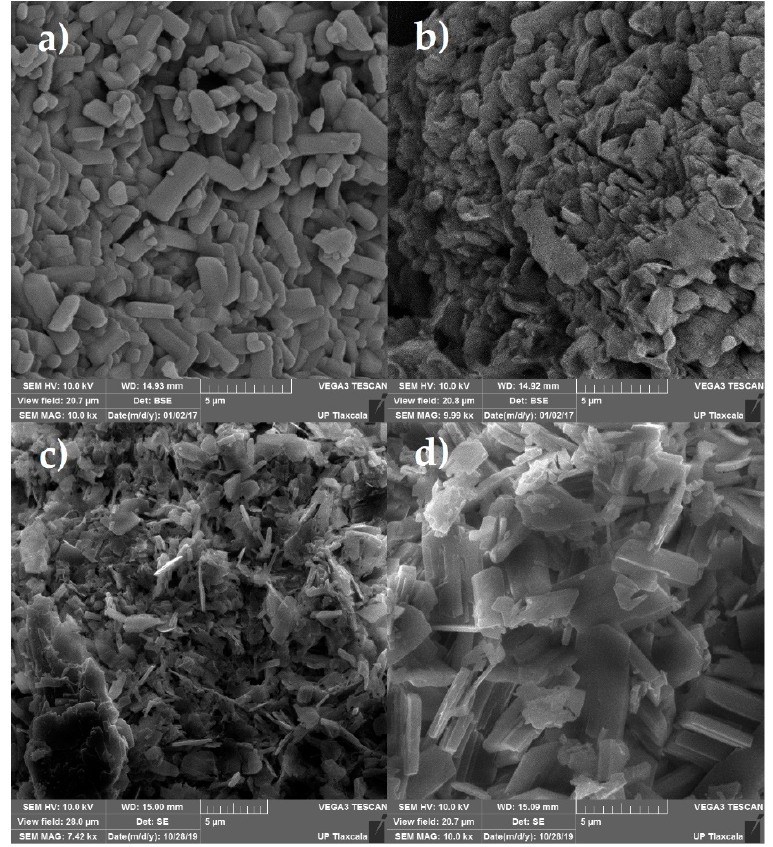
Figure 9. SEM images of ( a ) NTZ-SUC cocrystals before the powder dissolution test, and the solid residues recovered after the dissolution experiments in the USP 1 apparatus: NTZ-SUC cocrystal formulated with ( b ) 1.0%, ( c ) 2.5%, and ( d ) 5% of Methocel ® 60 HG.